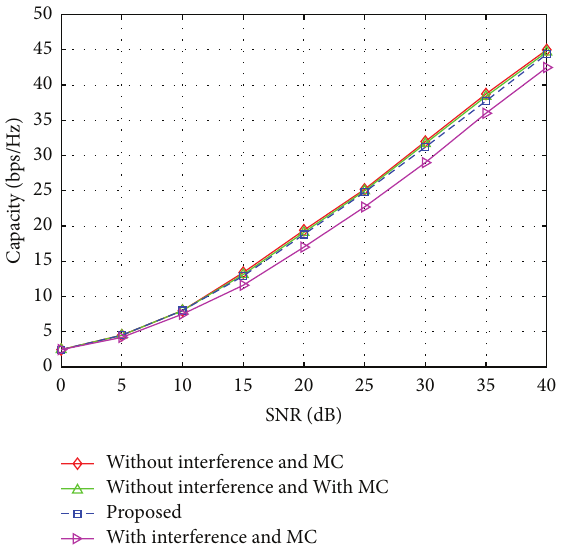
Figure 8: Channel capacity versus SNR for 80% interference reduc-